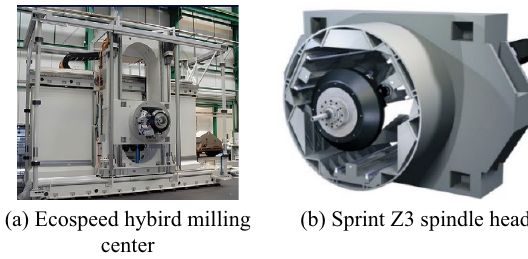
Figure 19 DS-Technologie products [68]